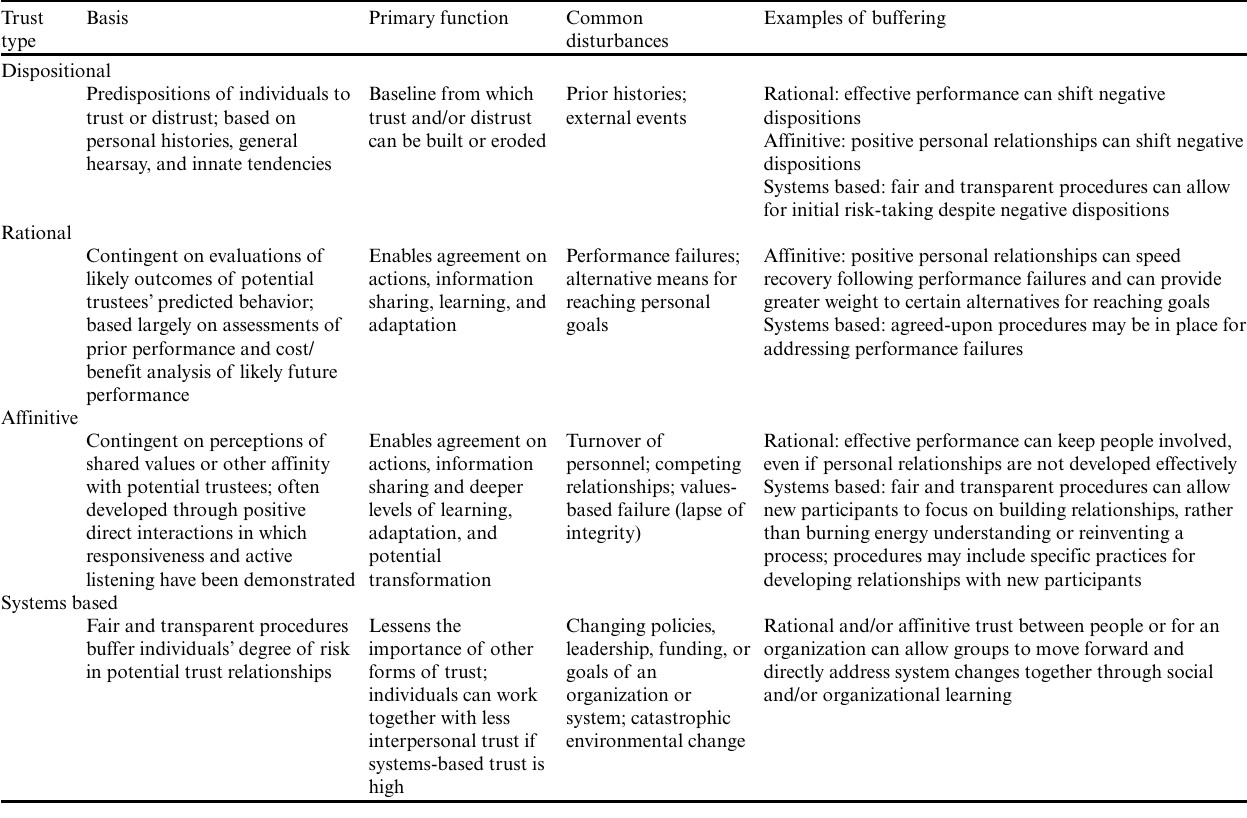
Table 1. Trust types and their bases, functions, and examples of how they buffer disturbances to other trust types. Trust